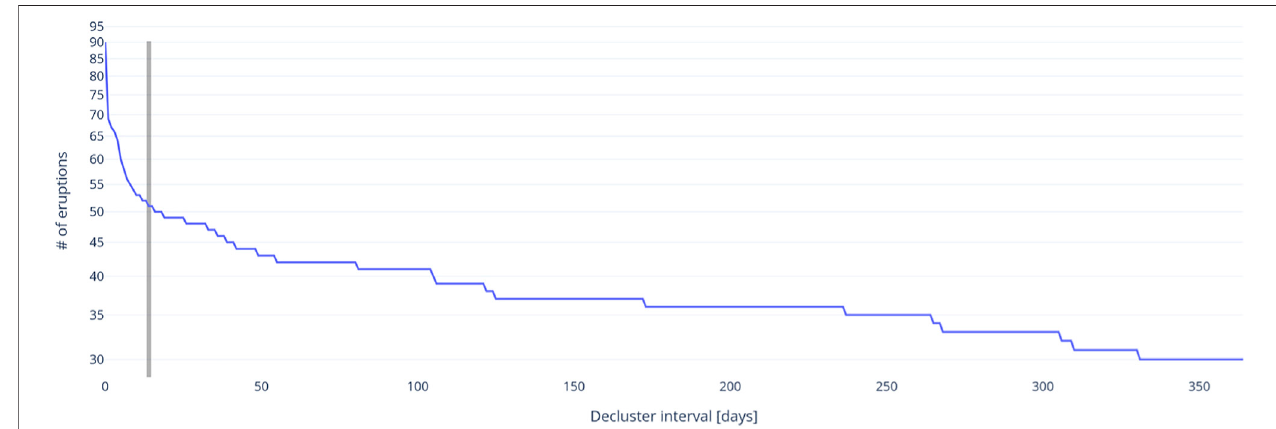
FIGURE6| Numberoferuptionscontainedineachde-clusteringinterval.Thechangeinslopeat14days,markedbytheverticalgreybar,isselectedastheoptimal de-clustering interval.